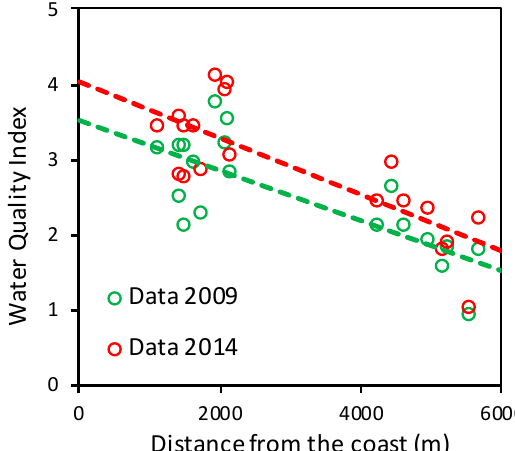
Figure 4. Observed water quality index plotted against the distance to the coastline and the fitted linear regression lines.